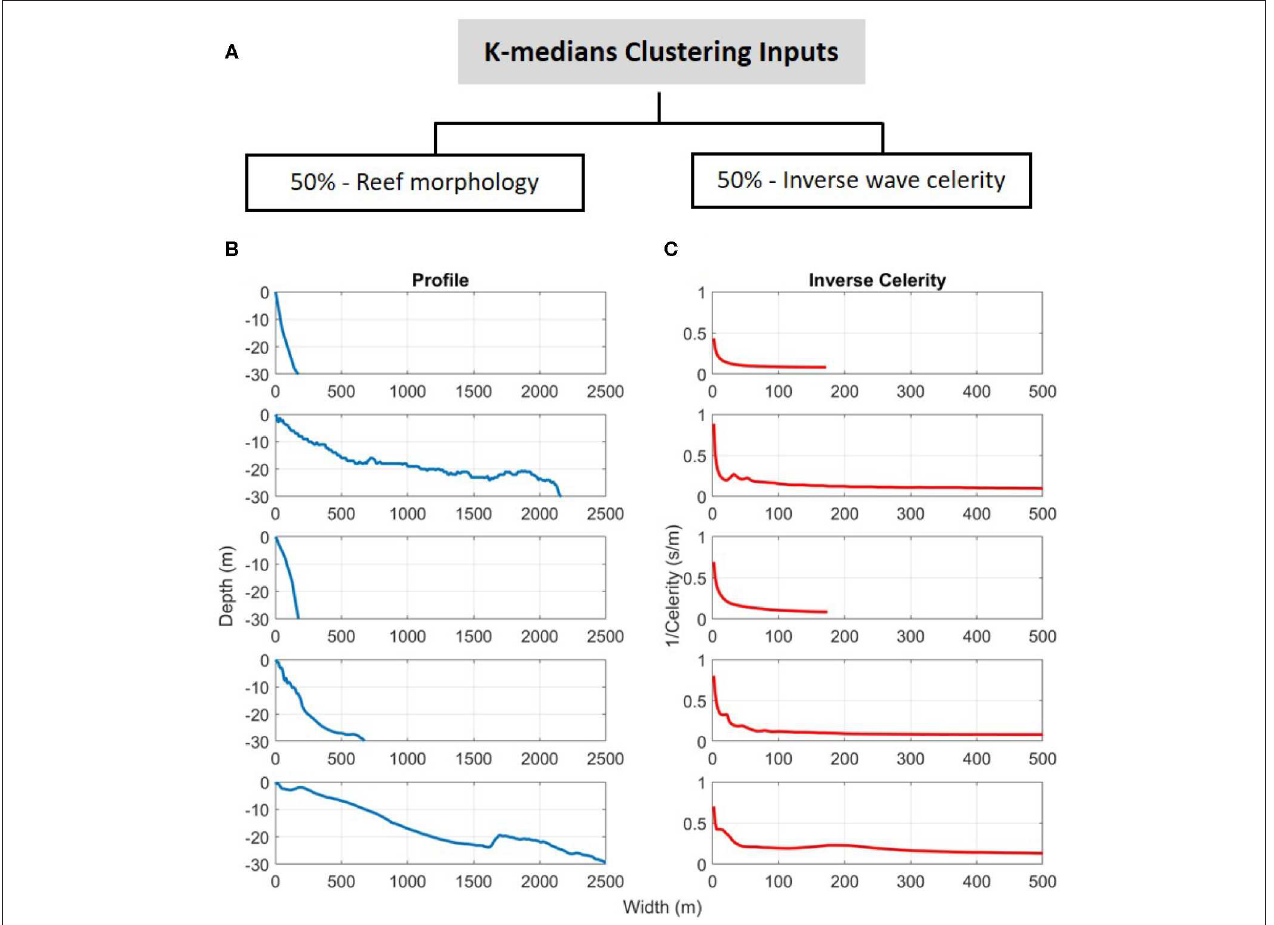
FIGURE 4 | The inputs used for the K-medians algorithm, (A) highlighting the weighting assigned to the two inputs; reef morphology and inverse wave celerity. (B,C) Examples of these two inputs for 5 topobathymetric cross-shore profiles.